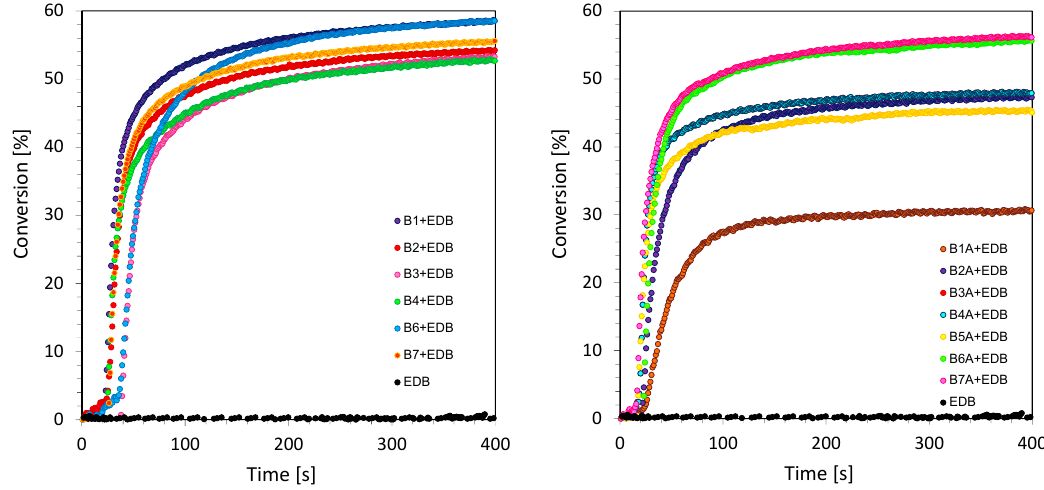
Figure 7. Photopolymerization profiles (double bond function conversion vs. irradiation time) in the presence of photoinitiating system based on biphenyls derivatives and EDB (0.5 / 1.5% w / w) at UV-A light LED source 365 nm for ( a ) 2-amino-4-methyl-6-(4-phenylphenyl)benzene-1,3-dicarbonitrile derivatives (series 1) and ( b ) 2-amino-4-methyl-6-phenyl-benzene-1,3-dicarbonitrile derivatives (series 2).